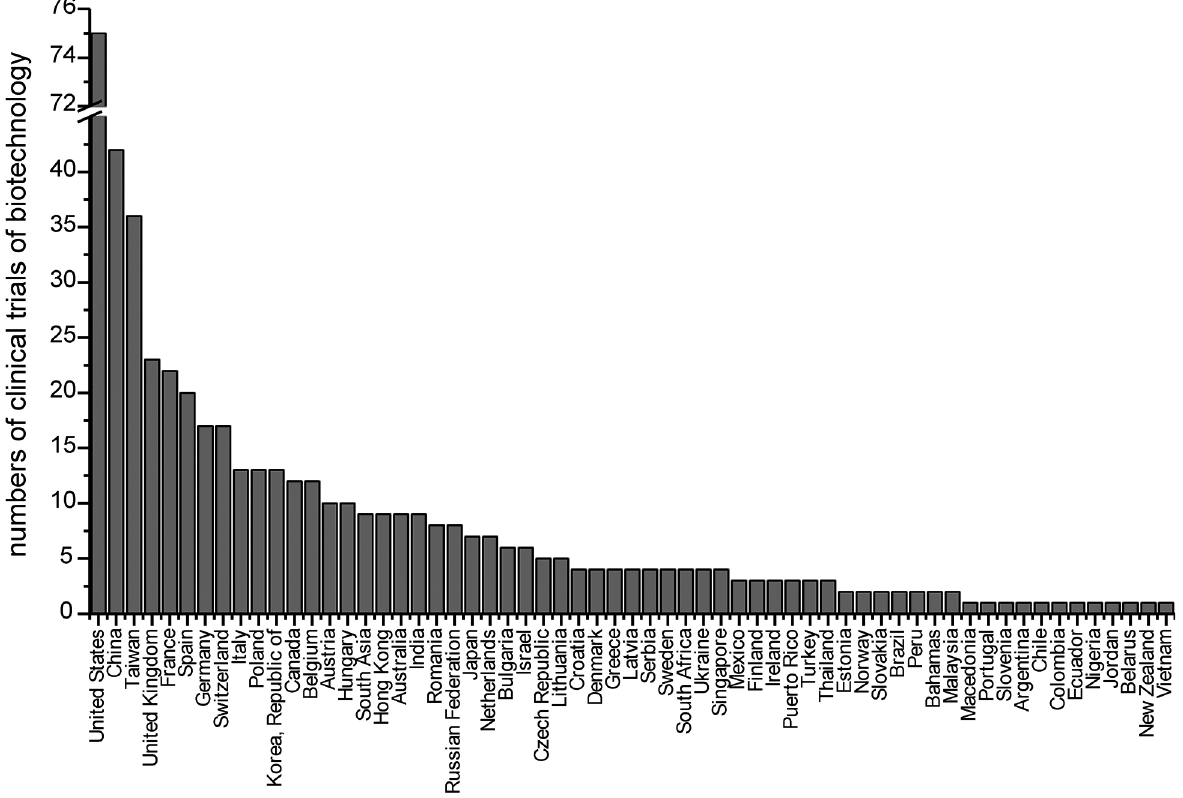
Fig. 3. Number of clinical trials in biotechnology according to the U.P. National Institute of Health Source: own calculations based on U.P. National Institute of Health